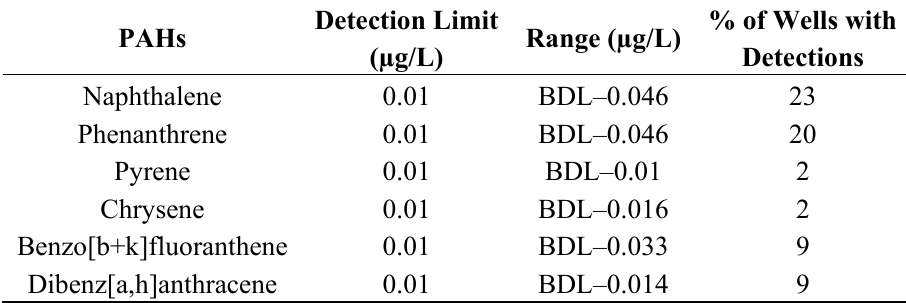
Table 3. Concentrations of polycyclic aromatic hydrocarbons (PAHs) from Walloon Coal Measures’ CSG waters, as sampled from production wells. Only detected PAHs are shown. BDL = below detection